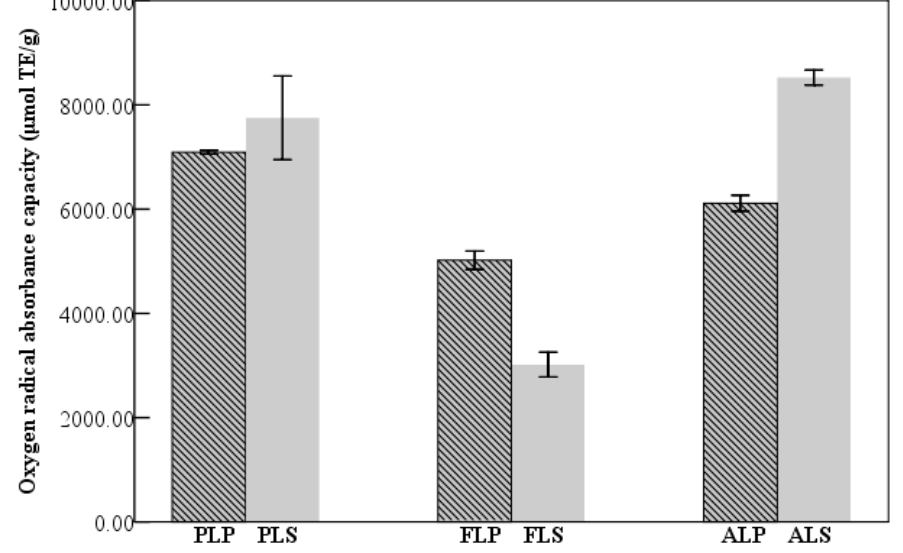
Figure 3. Oxygen radical absorbance capacities of longan byproducts. PLP: phenolic in longan pericarp, PLS: phenolic in longan seed, FLP: flavonoid in longan pericarp, FLS: flavonoid in longan seed, ALP: alkaloid in longan pericarp, ALS: alkaloid in longan seed, and TE: Trolox equivalent.